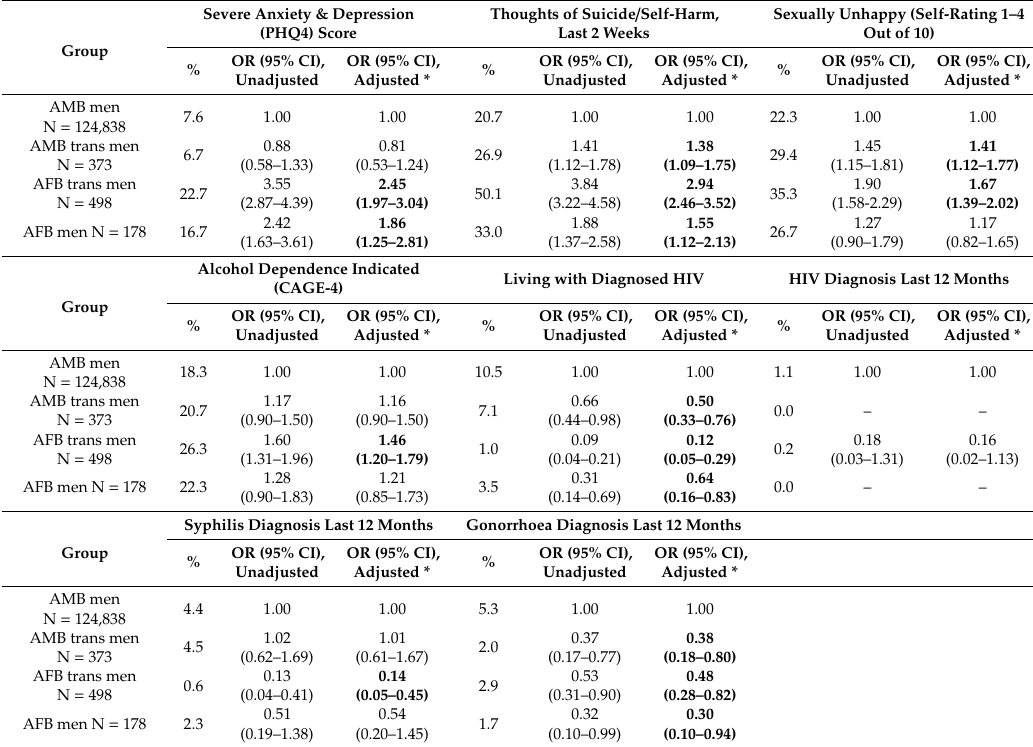
Table 2. Morbidity indicators across four sex-assigned-at-birth / current-gender-identity subgroups of MSM.